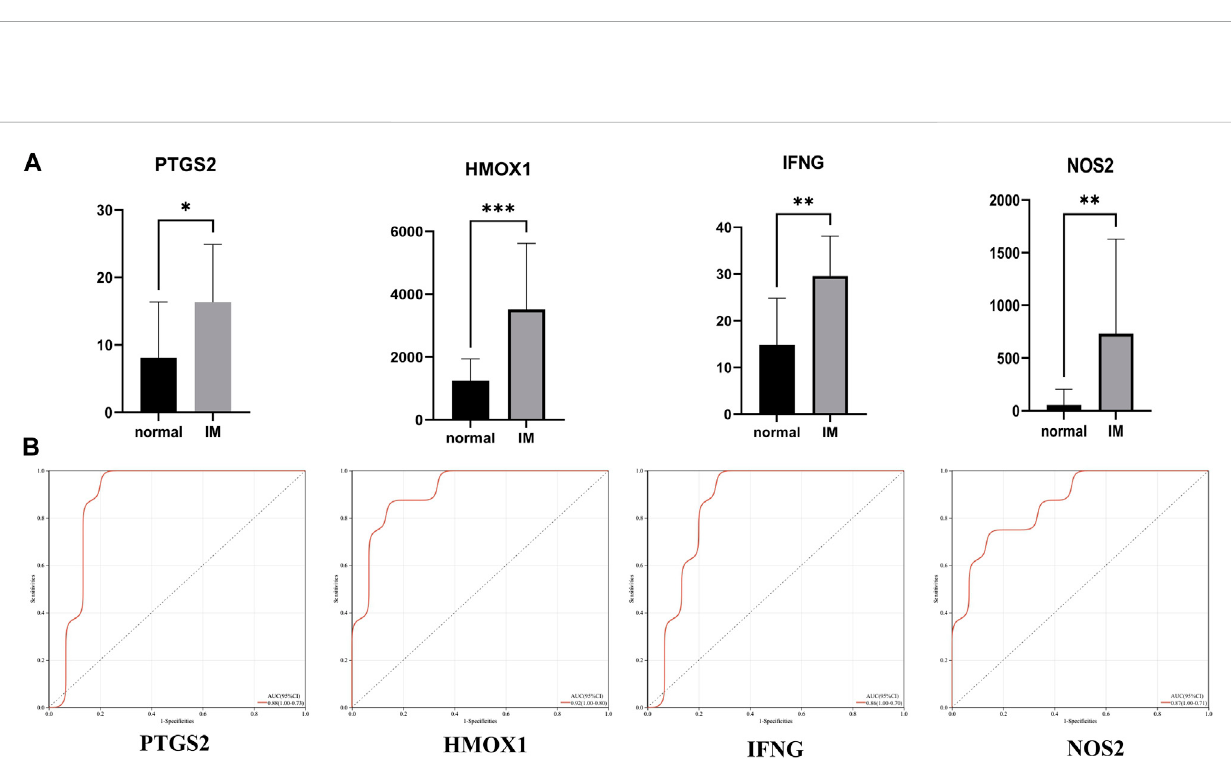
FIGURE 4 PPI network of ferroptosis DEFRGs. (A) The PPI among 17 differentially expressed ferroptosis-related genes. (B) Key module of the PPI network screened by MCODE plugin. (C) Hub genes screened by cytoHubba plugin.